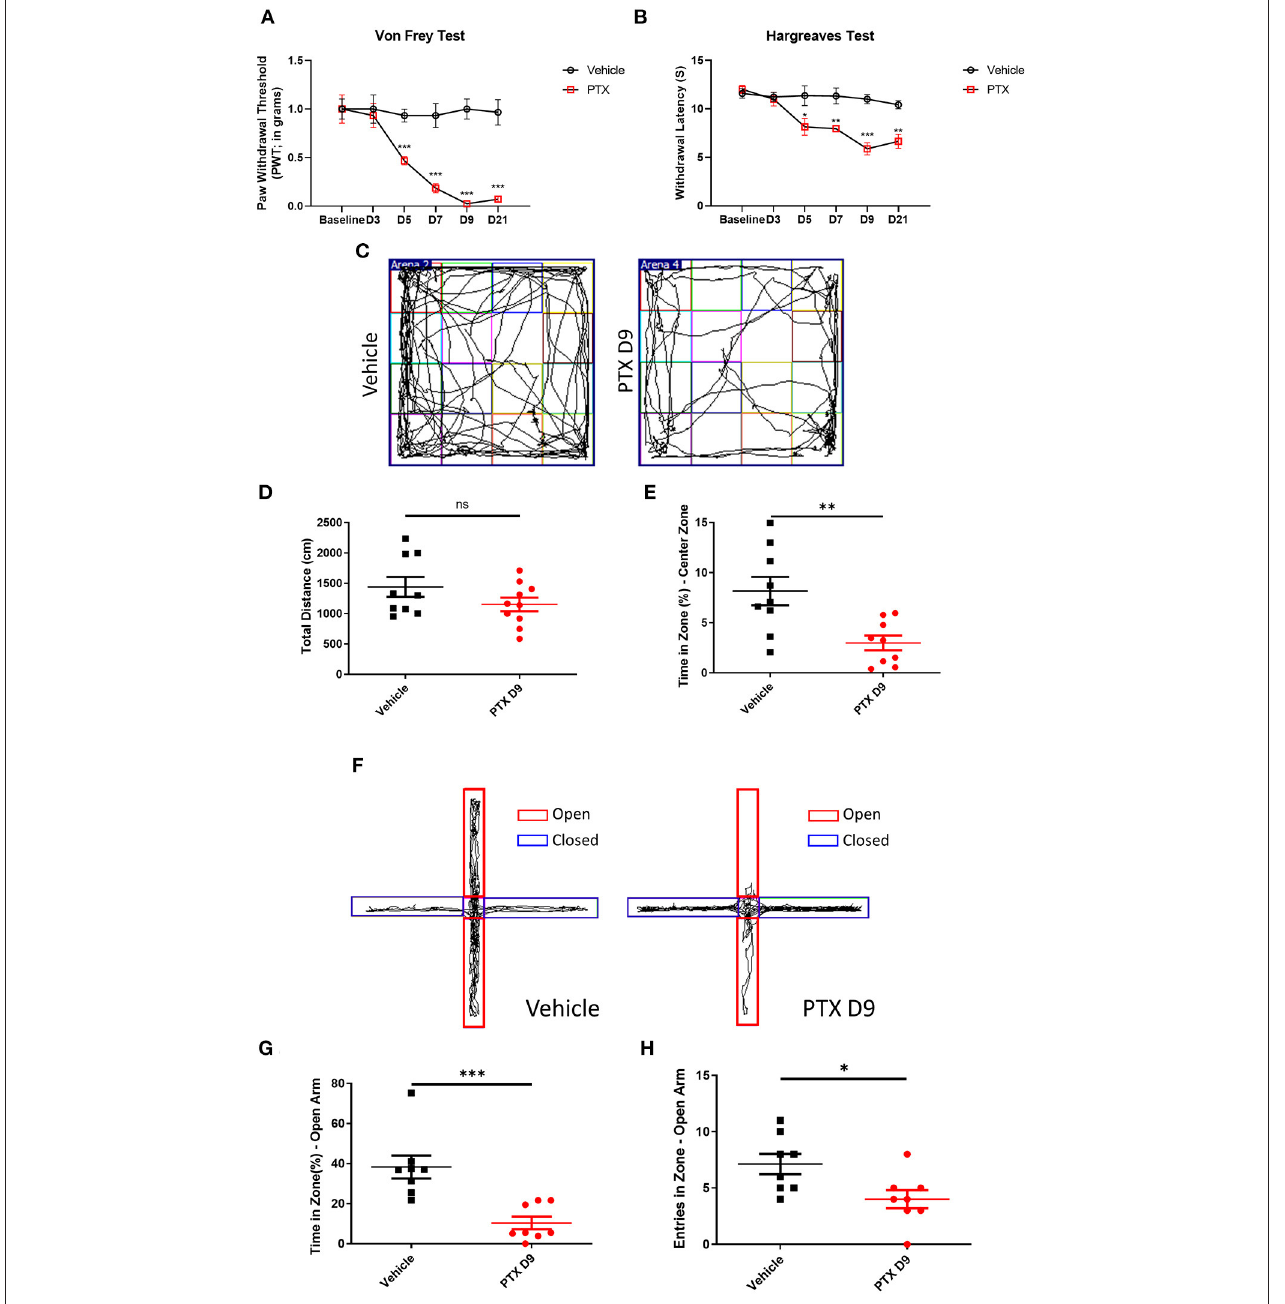
FIGURE 1 | Establishment of paclitaxel chemotherapy pain model. (A,B) The behavioral changes of paw withdrawal thresholds and paw withdrawal latencies in the vehicle group and paclitaxel group at different time. (C) Open field test trajectory diagram of vehicle and paclitaxel groups. (D) Total distance statistics of the vehicle group and paclitaxel group. (E) The statistical results of the percentage of central area activity time in the vehicle group and paclitaxel group. (F) The trajectory diagram of the elevated plus maze test in the vehicle and paclitaxel groups. (G) Statistic results of the percentage of open arm entry time in the vehicle group and paclitaxel group. (H) Statistic results of the number of entries open arm in the vehicle group and paclitaxel group. n = 6–9, ns, no significant, * P < 0.05, ** P < 0.01, *** P < 0.001.